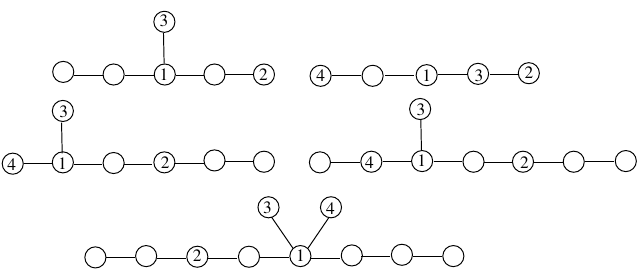
Figure 2: Examples of minimal trees of diameter d with 4 ≤ d ≤ 7 .